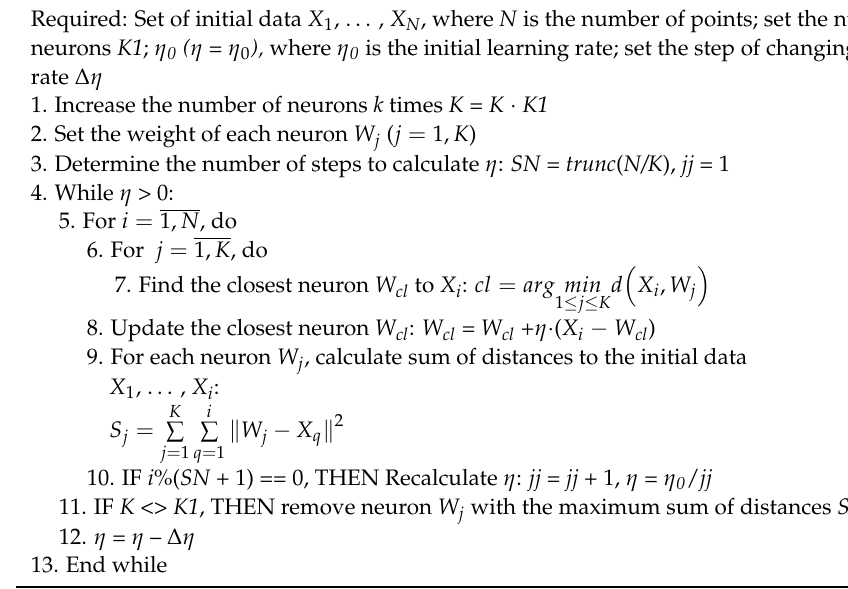
Algorithm 3. SCL-based algorithm with a greedy agglomerative heuristic